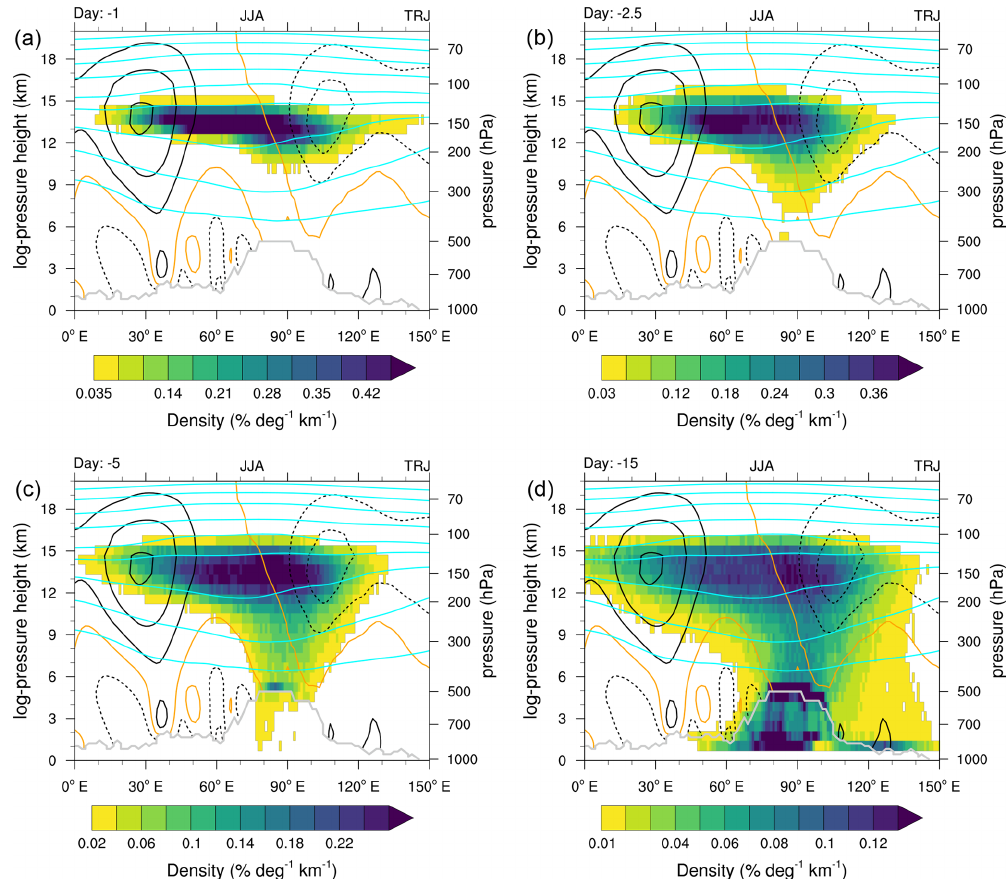
Figure 5. Longitude versus log-pressure height cross sections of density distributions (%deg − 1 km − 1 , i.e. percent per degree per kilometre) of trajectory positions for PBL crossing trajectories (a) 1d, (b) 2.5d, (c) 5d and (d) 15d prior to their arrival at 150hPa within the AMA. The three-dimensional probabilities were integrated over 0–50 ◦ N. Please note the different colour bars. Once trajectories reach the PBL, their pathways are not followed back any further. Instead, they are also noted at their first PBL-crossing points for analyses going back further in time. For example, if a trajectory already reaches the PBL after 3d, it will also be counted at this PBL-crossing position for the analysis 5 and 15d back in time. Please note – also for upcoming figures – that the maximum in the distribution at 4–6km, for example, present in panel (d) , is related to the TP. Cyan lines indicate potential temperature levels at 30 ◦ N starting at 340 to 380K in steps of 10 and 20K afterwards (380 to 480K). Black contours indicate meridional winds at 30 ◦ N in steps of 3ms − 1 . Negative, i.e. southward, winds are dashed, and the zero wind line is given in orange. Meteorological data based on ERA-Interim are flagged out below the grey line, which indicates the ERA-Interim minimum surface pressure in the region 0–50 ◦ N of the time average JJA for the trajectory